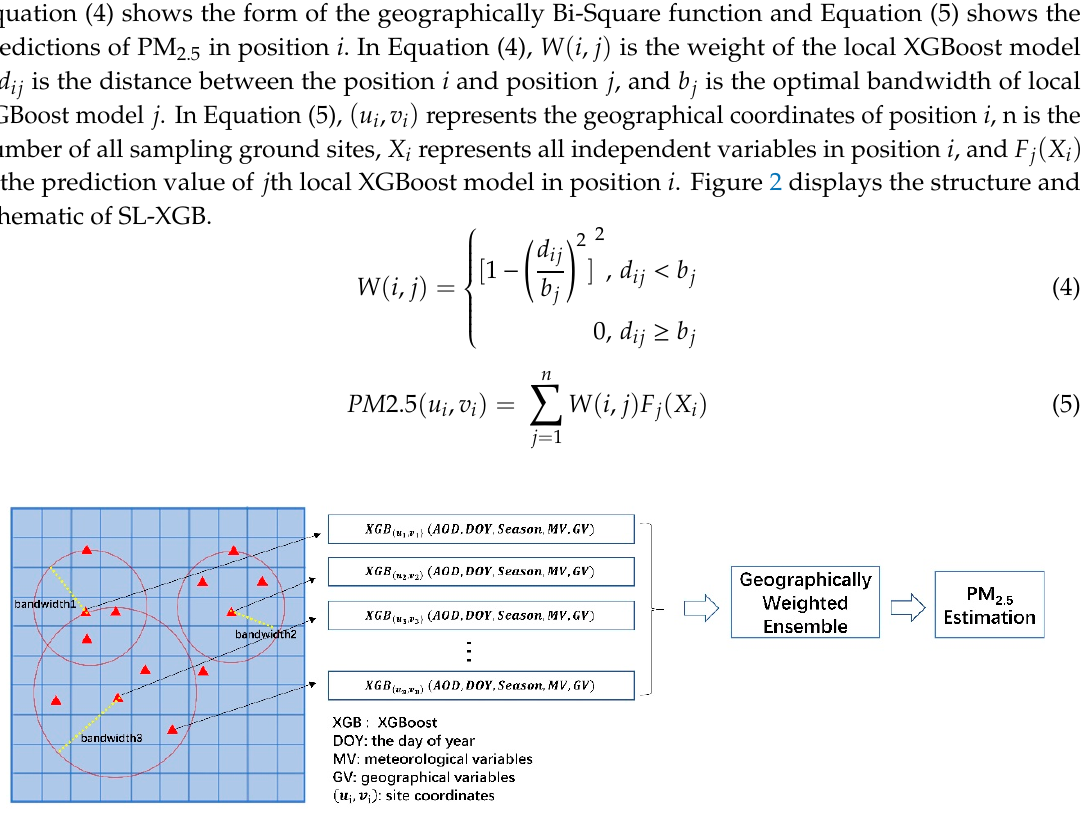
Figure 2. The structure and schematic of the SL-XGB model for PM 2.5 estimation.